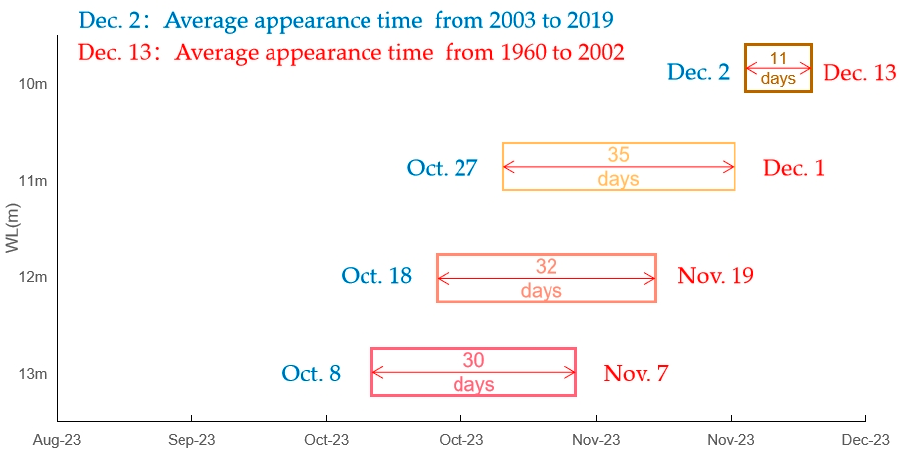
Figure 5. Monthly variation of the average water level at the Xingzi hydrometric station during the dry season (unit: m).